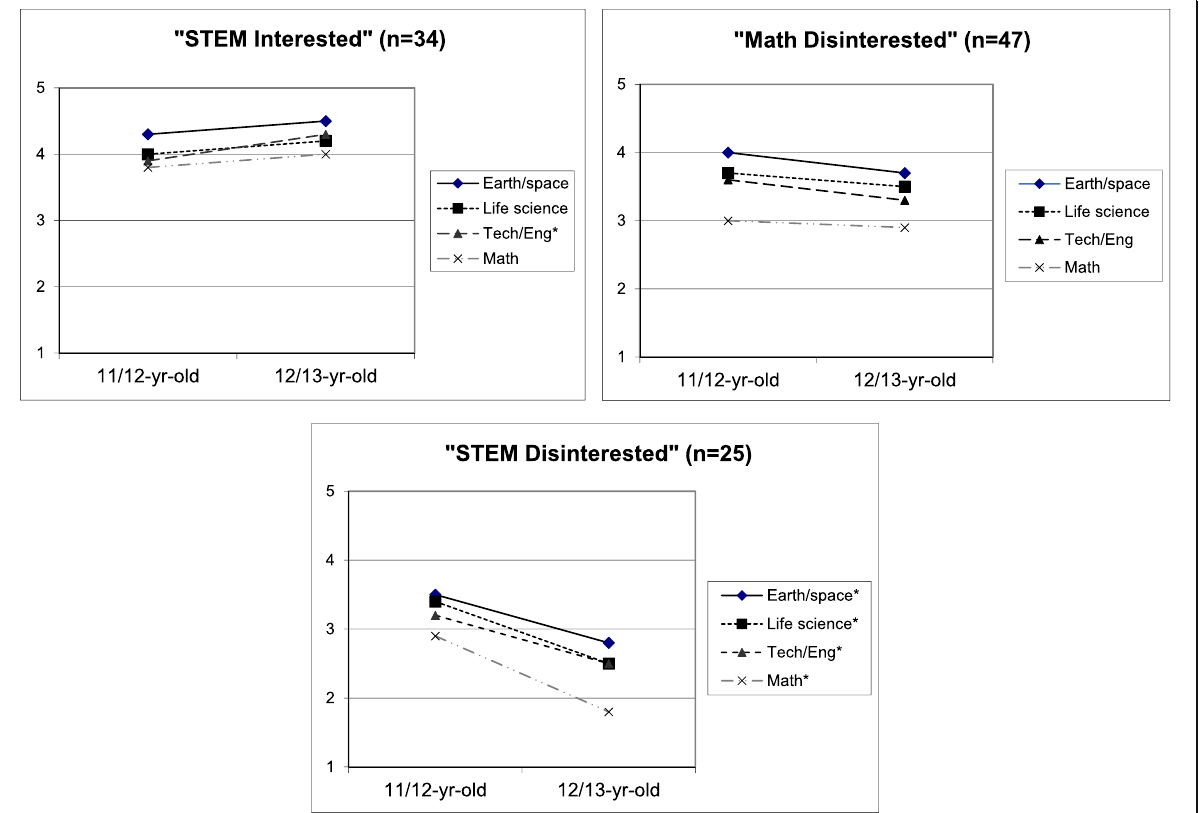
Fig. 3 STEM interest pathways for youth aged 11/12 (sixth grade) and 12/13 (seventh grade) years-old by STEM Interest Profile. Interest scores ranged from 1 = “ Not interested ” to 5 = “ Very interested. ” Trajectories with an asterisk denote significant differences at the p < 0.05